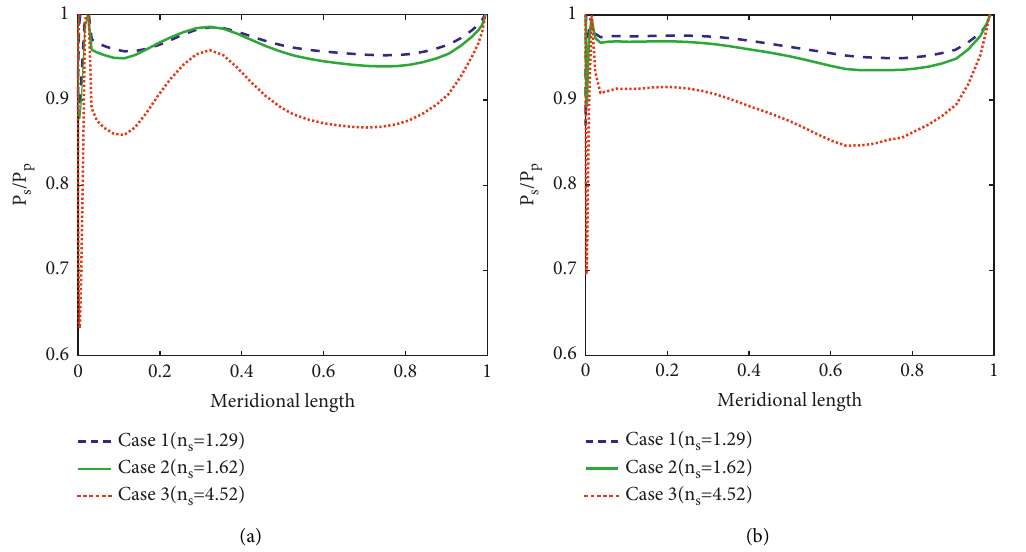
Figure 24: P s / P p along the impeller meridional length. (a) At 85% of the span. (b) At 15% of the